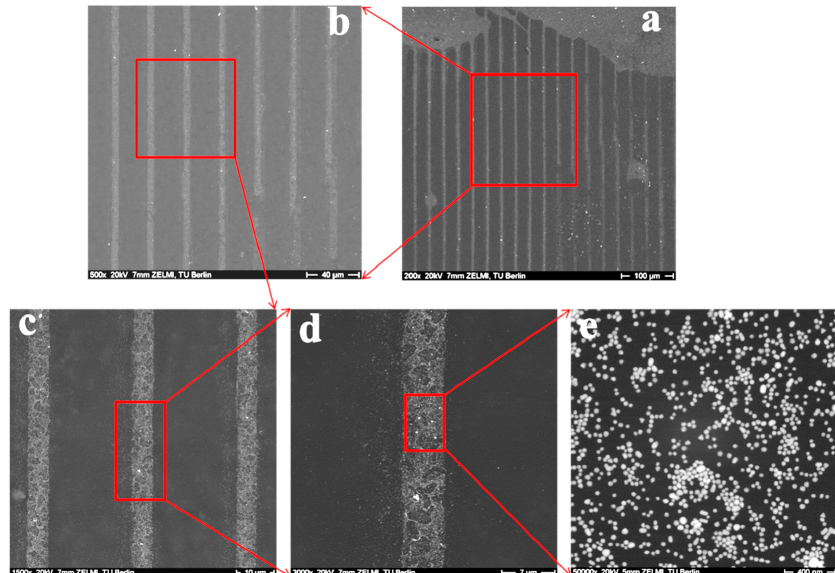
Figure 7 . SEM images of patterned Au NPs on the surface of 8PEG-VS-SH hydrogels. Scale bar ( a ) 100 μ m; ( b ) 40 μ m; ( c ) 10 μ m; ( d ) 7 μ m; ( e ) 400 nm. The size of Au NPs is 42 nm, the width of stripe is 10 μ m and the distance between patterned stripes is 50 μ m in the swollen state.